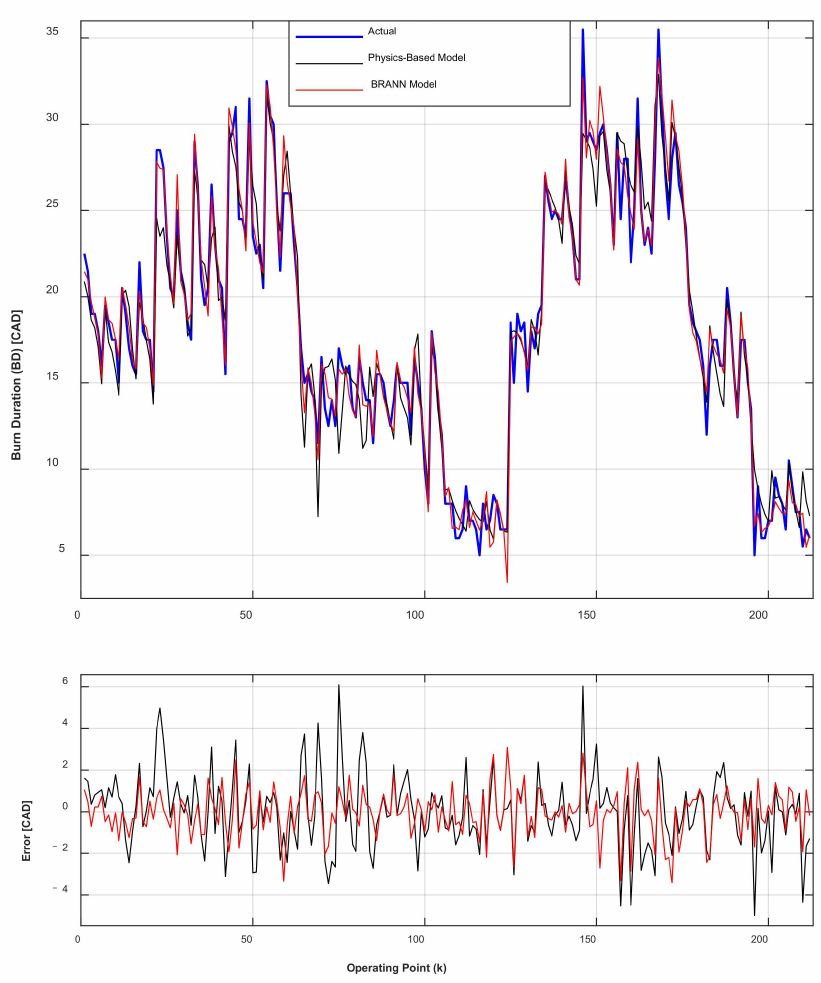
Figure 25. Comparison of the actual BD, physics-based model prediction, and ANN